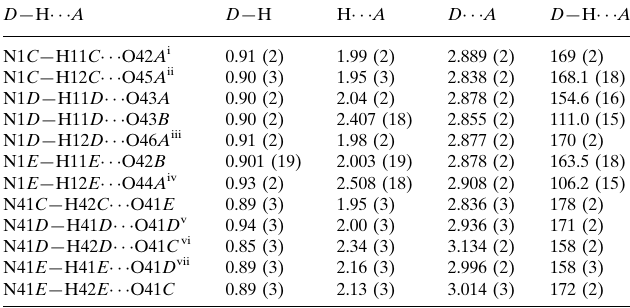
Hydrogen-bond geometry (A˚ , (cid:4) ). D —H (cid:2)(cid:2)(cid:2)